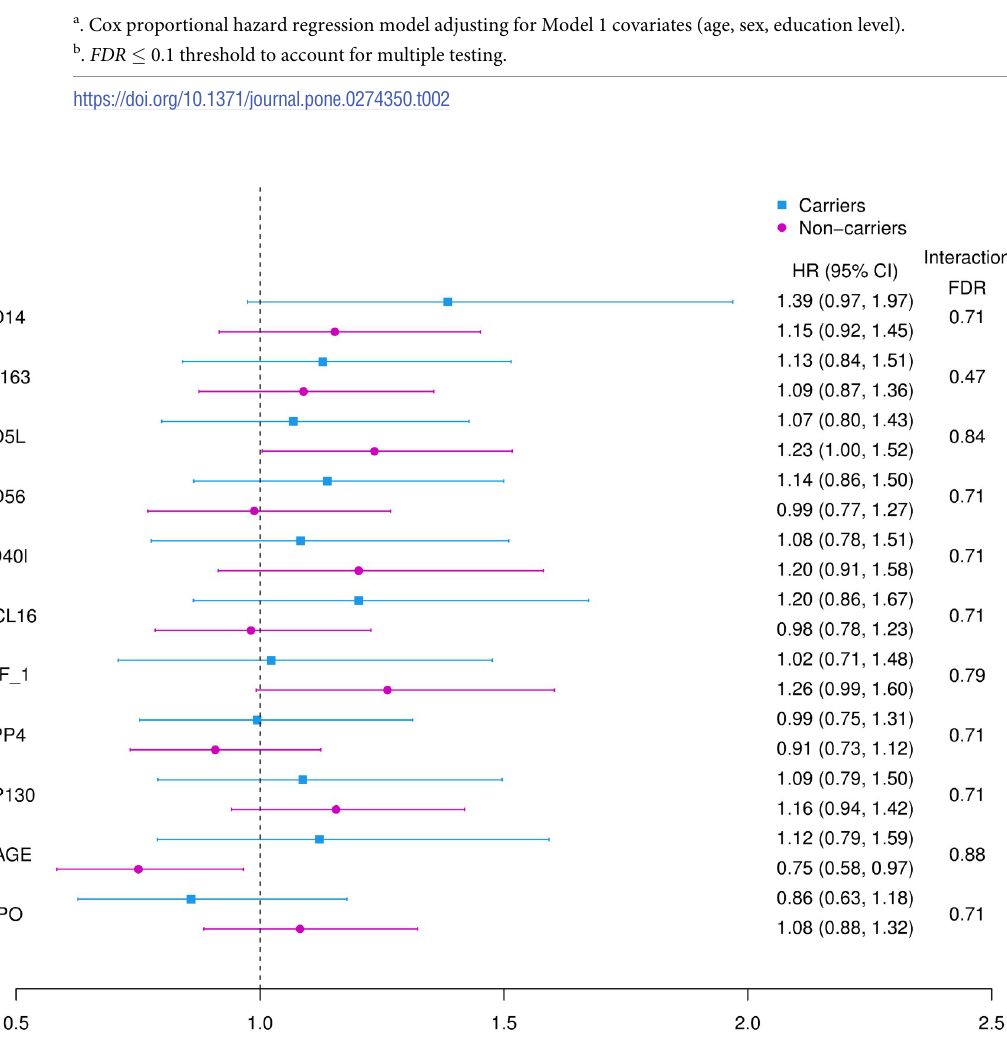
Fig 4. HR of incident dementia per SD unit higher protein biomarkers, stratified by APOE ε 4 carrier. Each color highlights the results from analyses using Cox proportional hazard regression models adjusting for Model 1 covariates (age, sex, and education level) in the carriers versus non-carriers subgroup. Points are effect estimates while lines indicate the 95% CI . APOE ε 4 carrier status interaction FDR are also